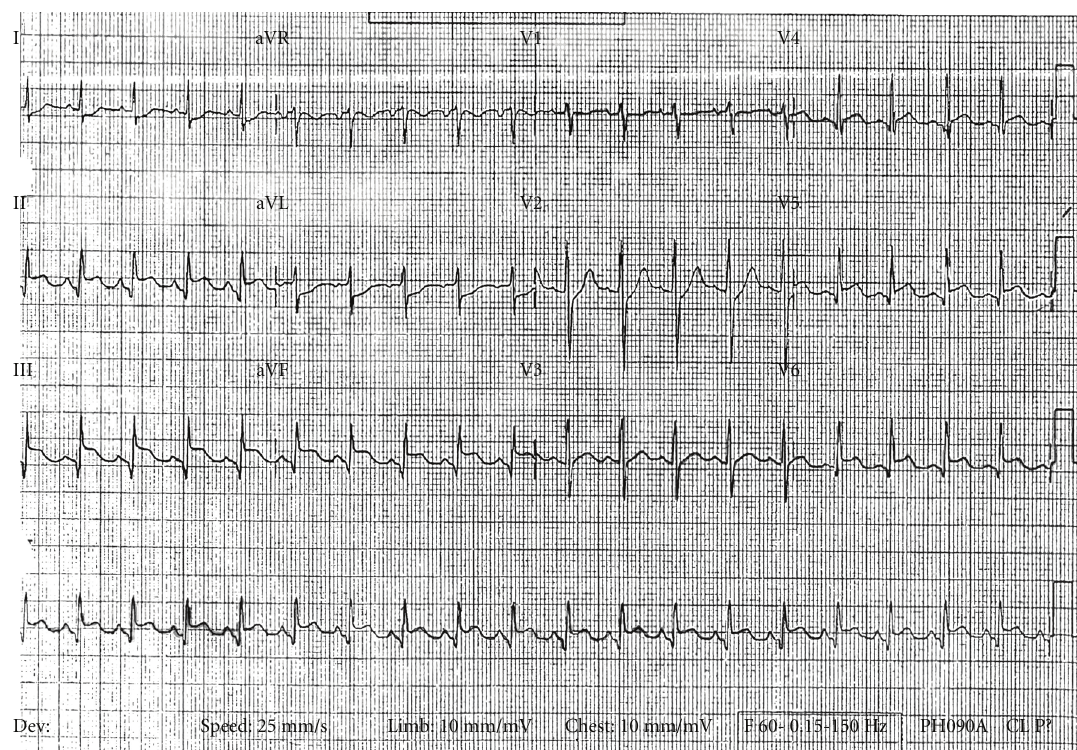
Figure 1: A 12-lead electro cardiogram showing ST elevations in lead II, III, AVF, V5, and V6.